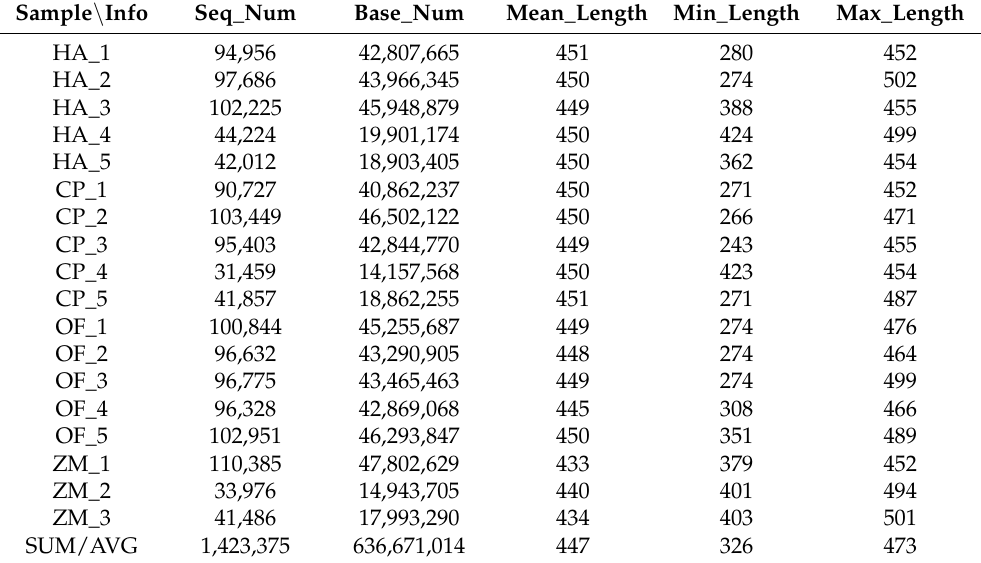
Table 1. Summary of sequence statistics for the Illumina MiSeq runs for all